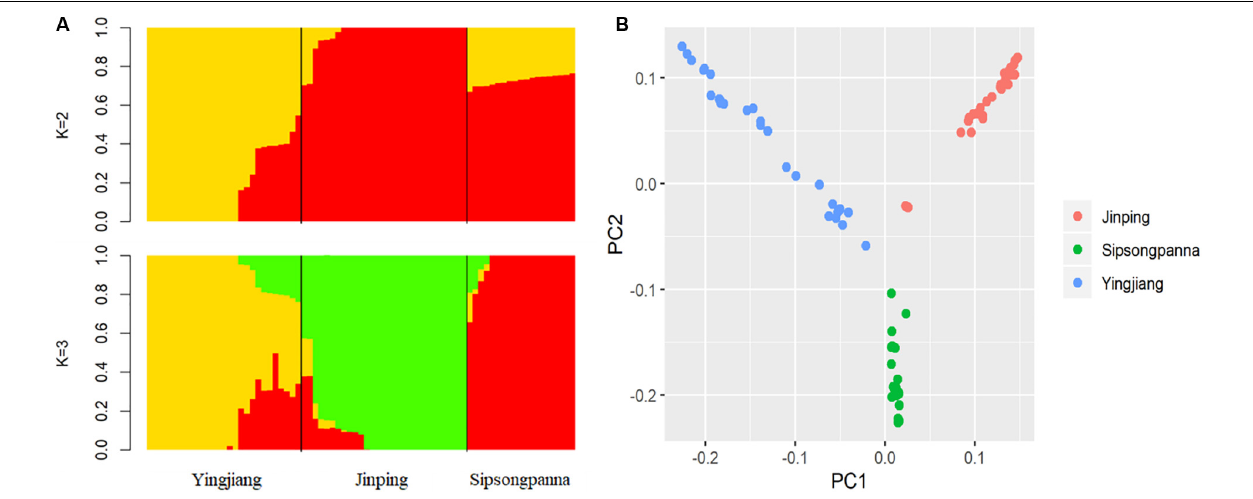
FIGURE 1 | (A) Shows admixture plot comprising ancestry numbers (K) at 2 and 3 of all the individuals; (B) shows principal components analysis of all individuals, and the x -axis denotes the first principal component, whereas y -axis represents the second principal component.